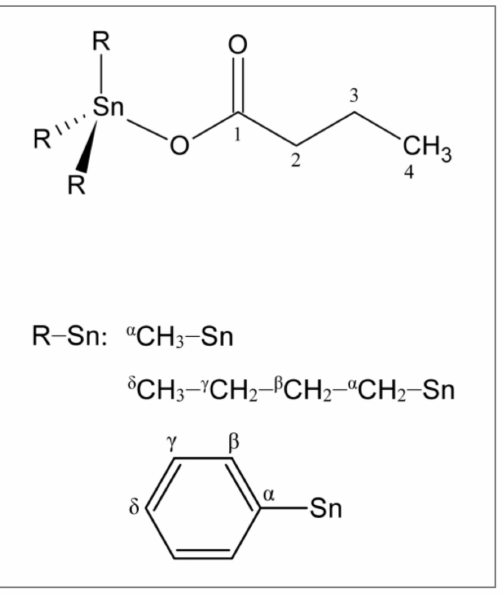
Figure 1. Proposed structure for R 3 Sn(IV) butyrates with the numbering scheme referred to the NMR